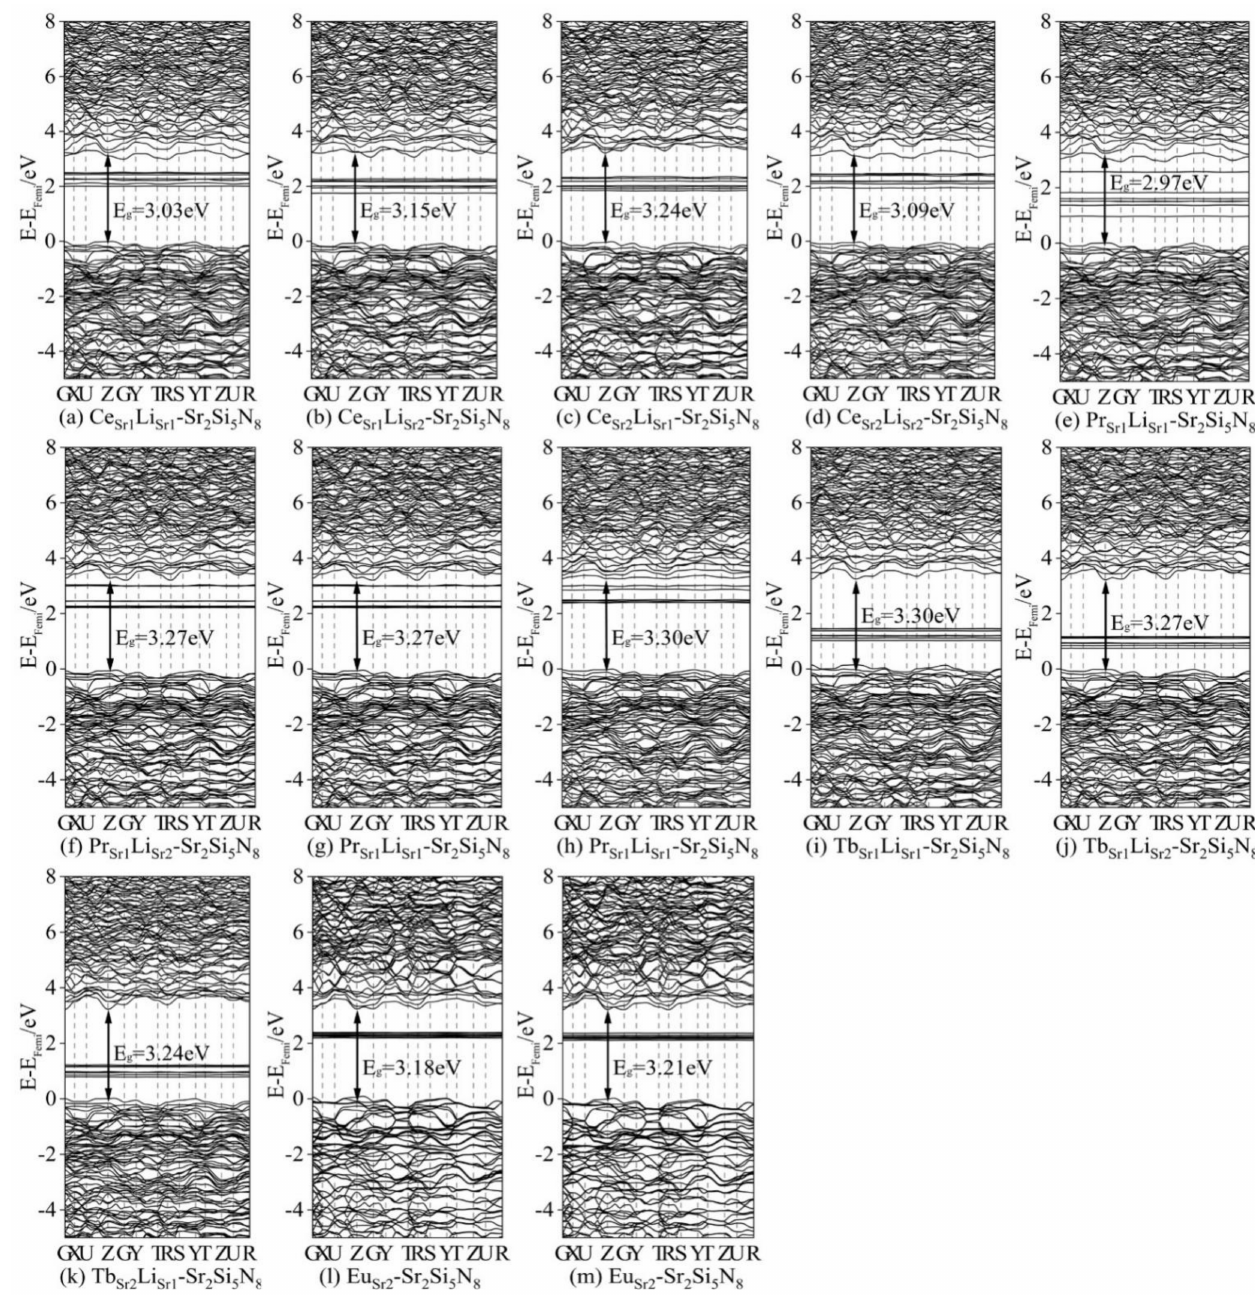
Figure 8. Band structures of doped structures: ( a ) Ce Sr1 Li Sr1 -Sr 2 Si 5 N 8 ; ( b ) Ce Sr1 Li Sr2 -Sr 2 Si 5 N 8 ; ( c ) Ce Sr2 Li Sr1 -Sr 2 Si 5 N 8